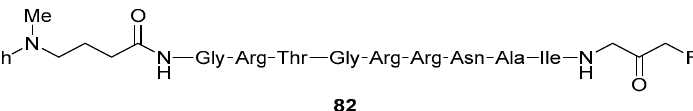
Figure 6. Peptidyl FMK possessing rhodamine B dye for studying PKAC α activity [8].